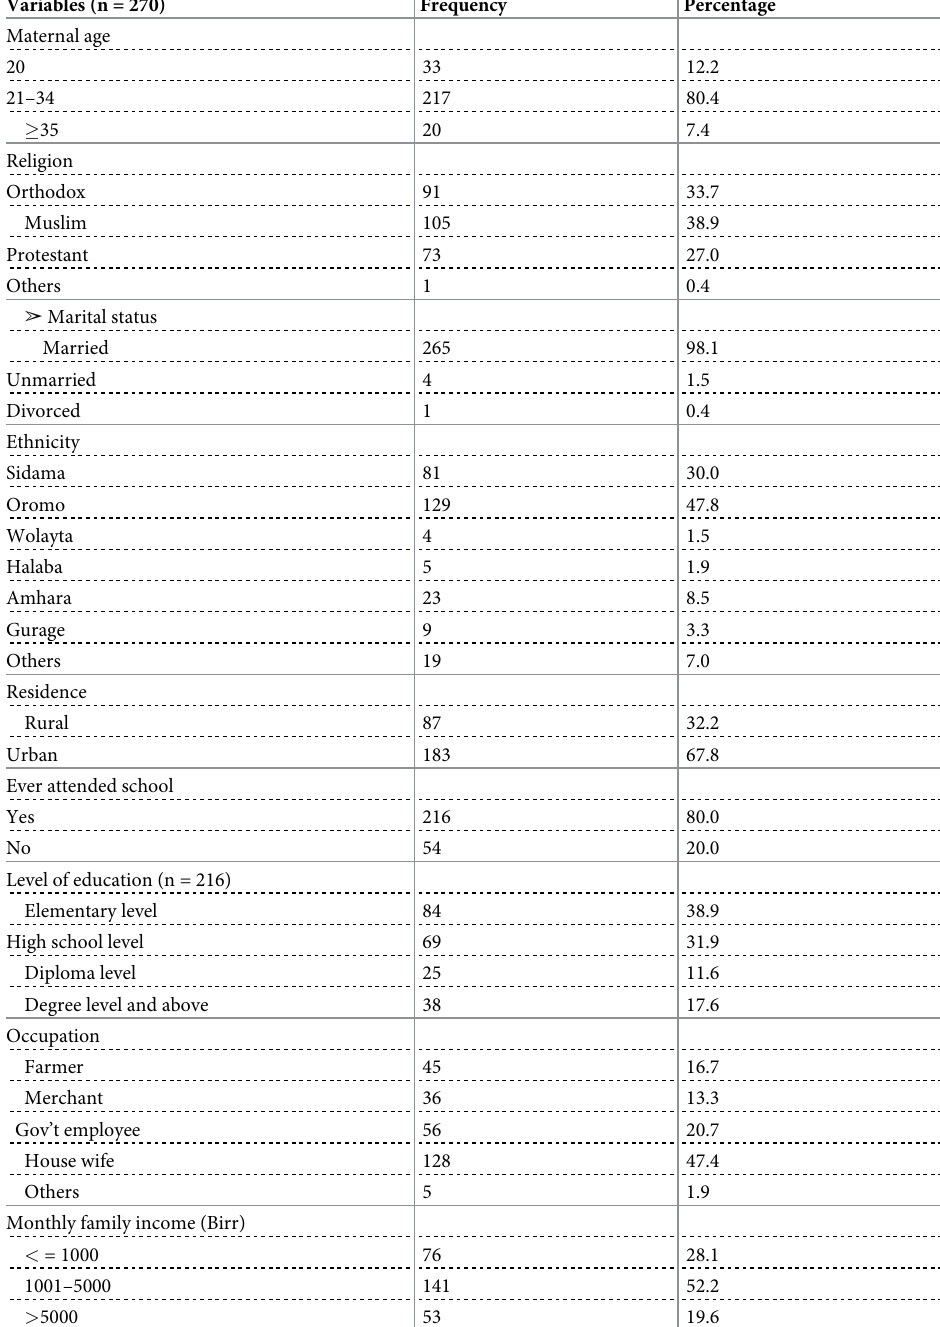
Table 1. Socio-demographic characteristics of mothers in Hawassa University comprehensive specialized hospital, Southern Ethiopia, October 2018. Variables (n =